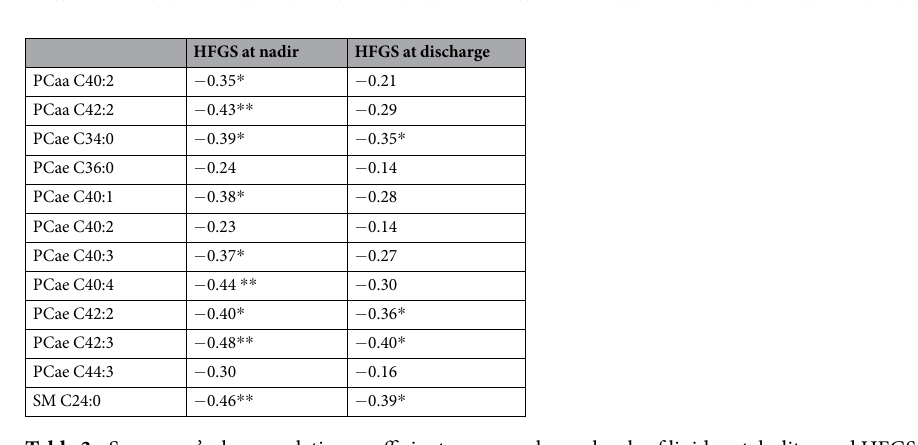
Table 3. Spearman’s rho correlation coefficients among plasma levels of lipid metabolites and HFGS of GBS patients at nadir and at discharge. * Correlation is significant at the 0.05 level. ** Correlation is significant at the 0.01